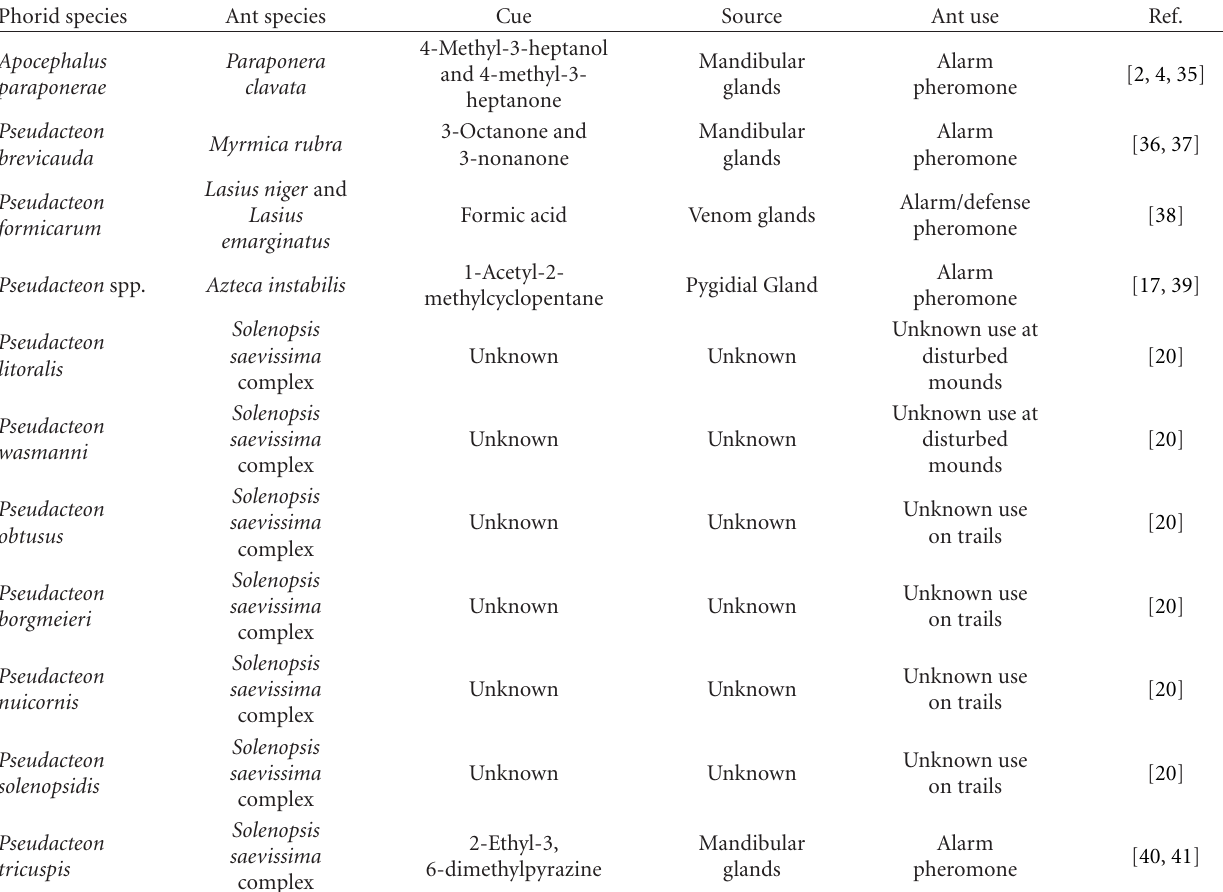
Table 1: Chemical host location cues used by phorid flies in search of ant